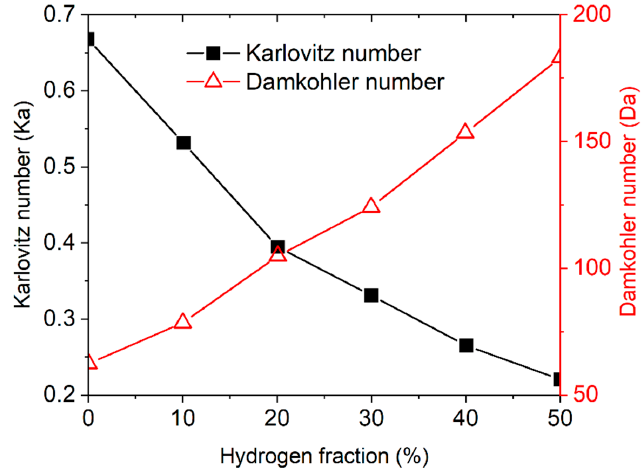
Figure 31. The curves of dependence of the Karlovitz and Damköhler numbers on the volume fraction of hydrogen in the mixture [30].